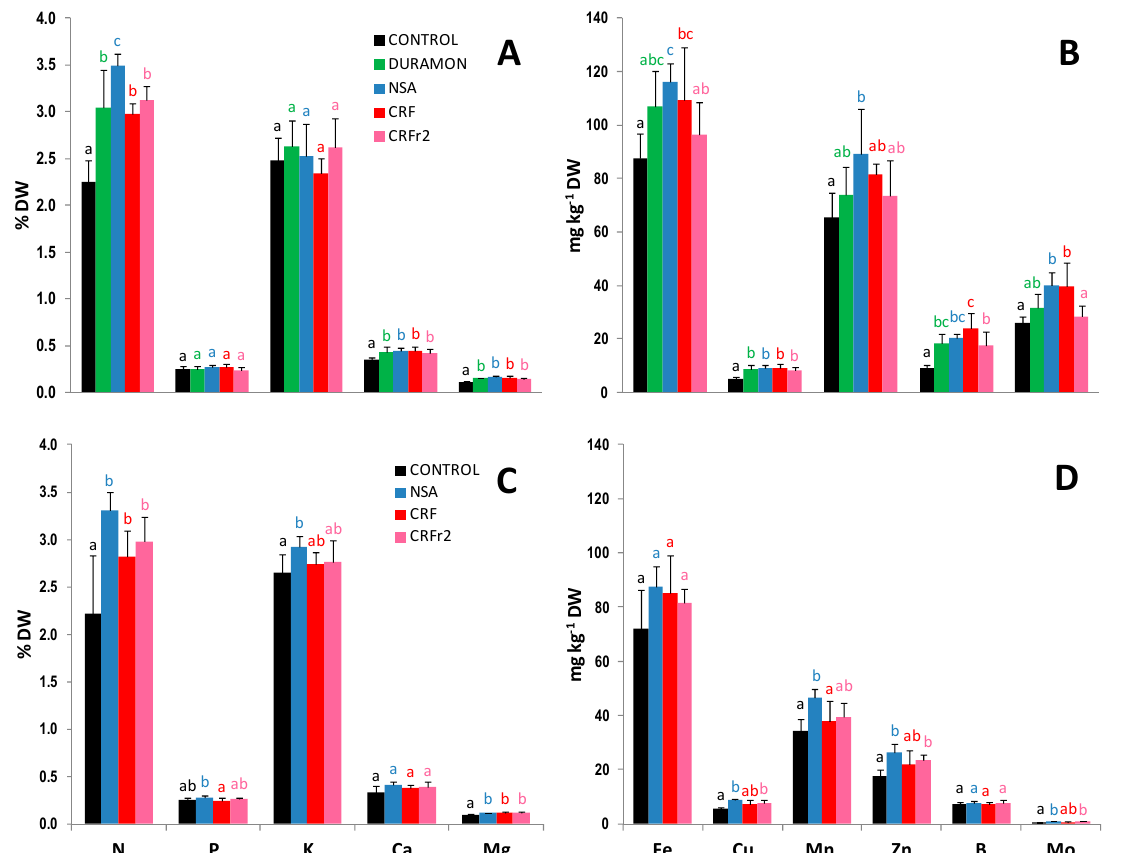
Figure 1. Macro ‐ and micronutrient foliar content comparisons of the maize fertilized with CRF, CRF r2 , DURAMON ® , ammonium nitrosulfate (NSA) and the untreated CONTROL on the microscale ( A , B ) and the field scale ( C , D ) experiments. The results for macronutrients (N, P, K, Ca, and Mg) were expressed as % leaf dry weight (DW) and micronutrients (Fe, Cu, Mn, Zn, and B) as mg kg − 1 leaf DW (Microscale ‐ CRF, DURAMON ® and NSA: 350 kg ha − 1 ; CRF r2 : 280 kg ha − 1 . Field ‐ CRF, NSA: 300 kg ha − 1 ; CRF r2 : 240 kg ha − 1 ). Values are means ± SD ( n leaf pools per treatment = 4). Different letters for a specific macro ‐ or micronutrient in each panel indicate statistically significant differences between treatments (ANOVA, p < 0.05).